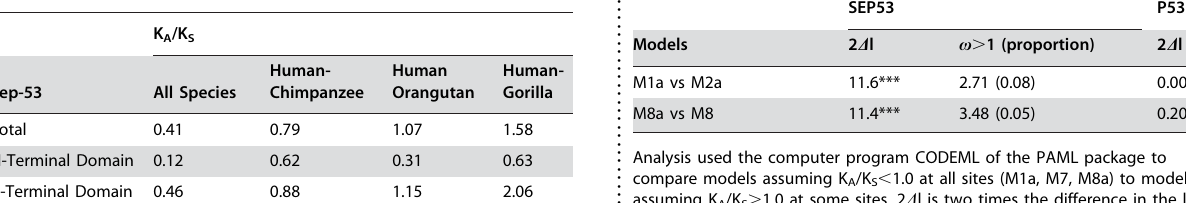
Table 2. Statistical tests for adaptive evolution